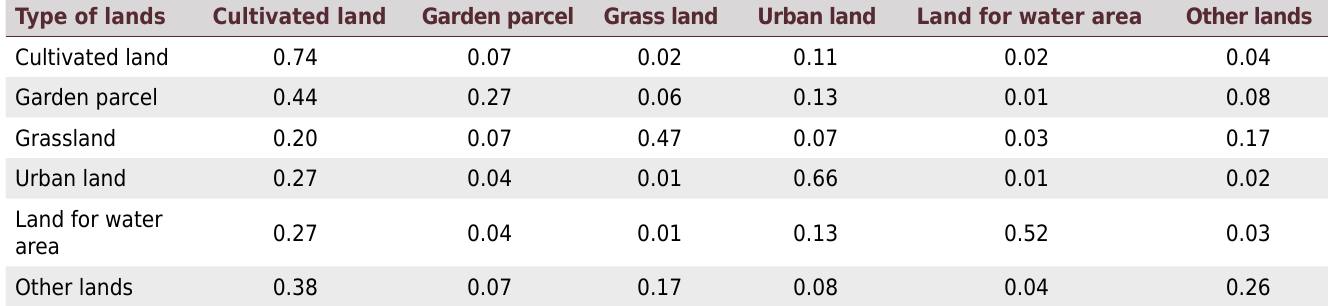
Table 4. Matrix of transition probabilities for land type utilizations in Huanghua City, China from 2006-2016 Type of lands